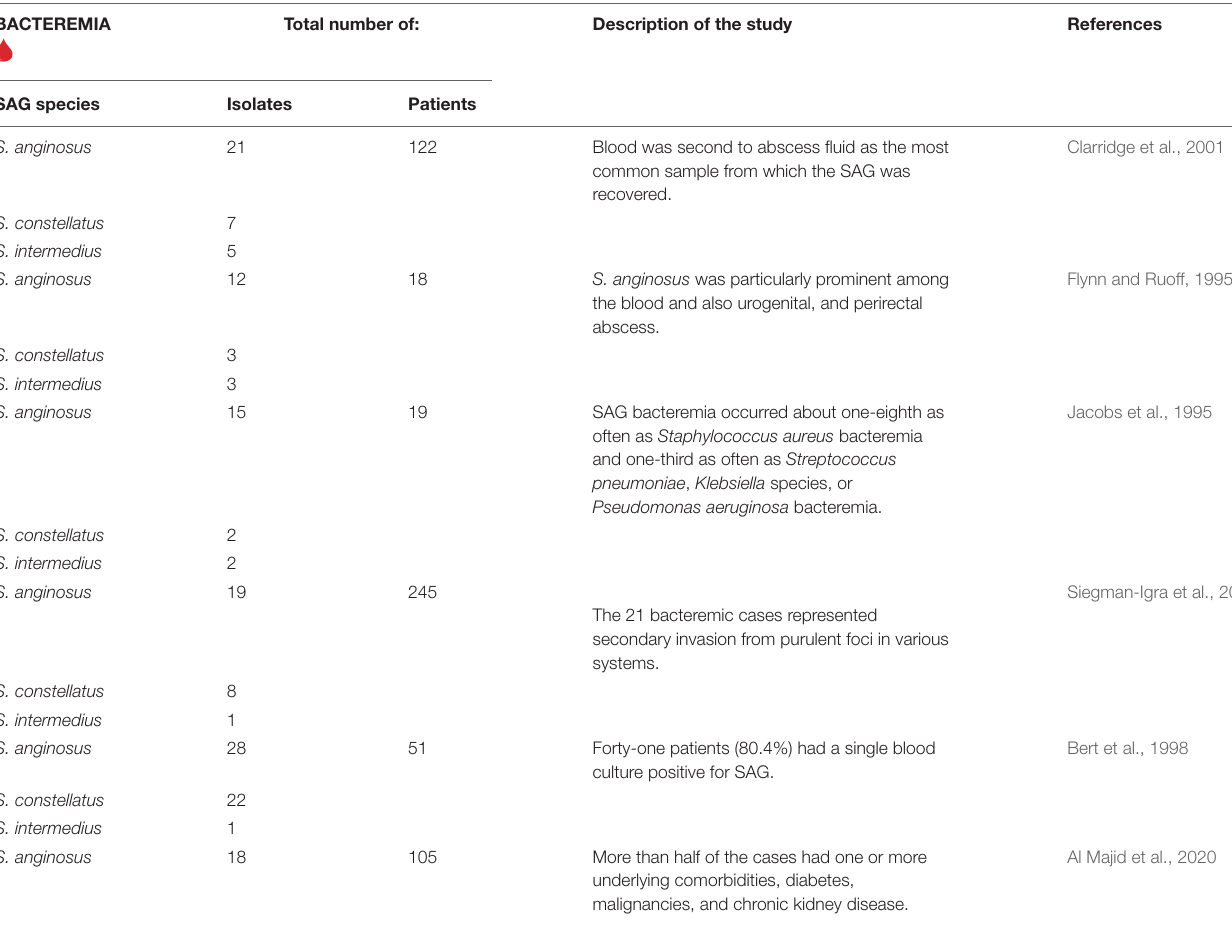
TABLE 1 | Streptococcus anginosus group-related bacteremia.